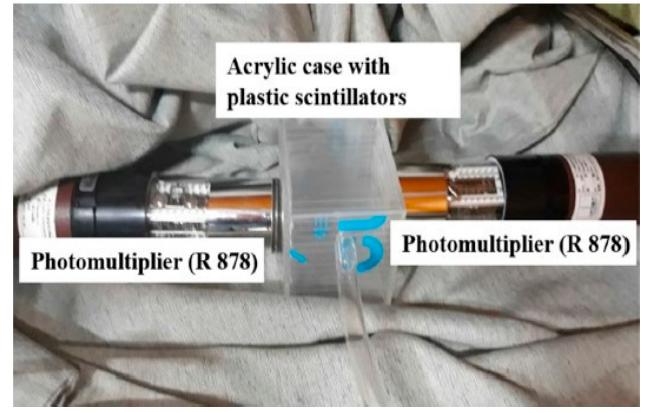
Figure 18. The flow cell detector probe [87].